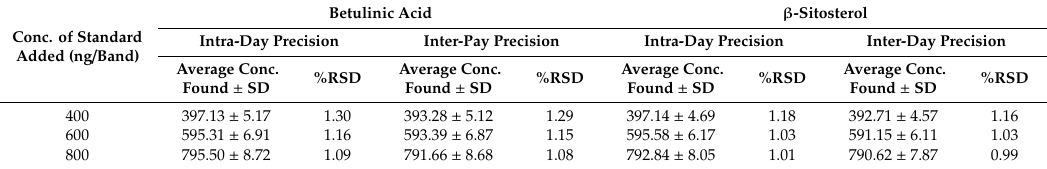
Table 5. Precision of the proposed HPTLC method (n =